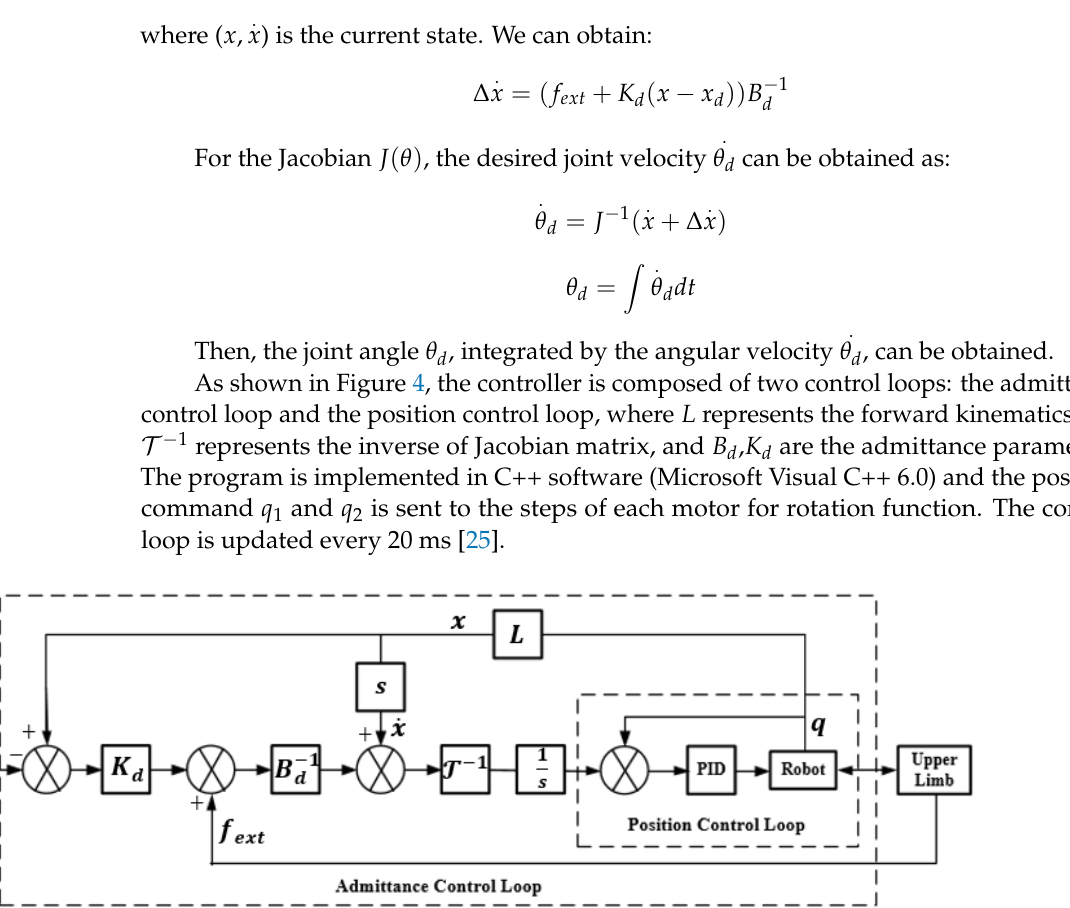
Table 1. The clinical characteristics of stroke patients.